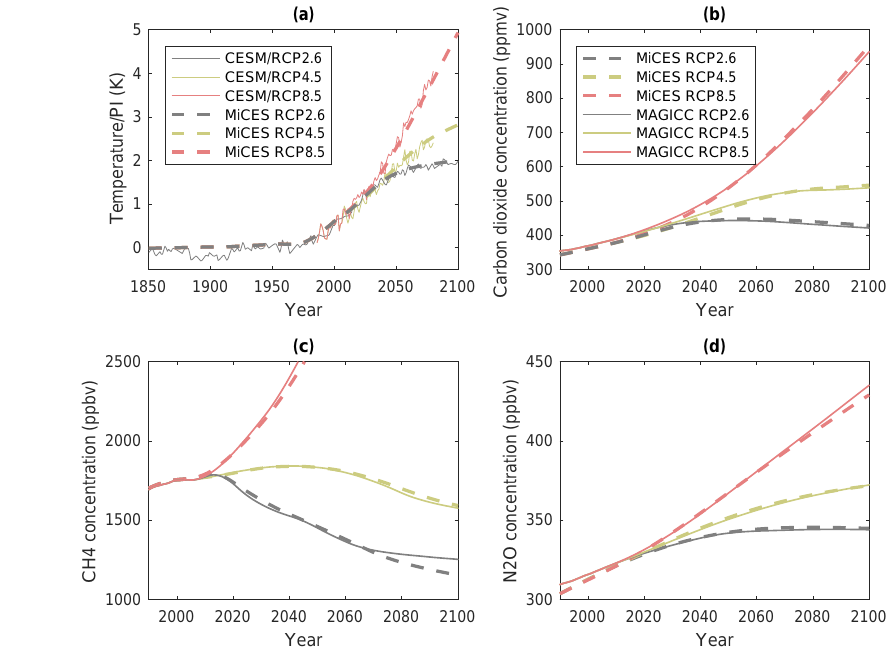
Figure B1. Calibrated behavior of the MiCES model in the context of the temperature targets (subplot a , target is CESM1-CAM5) and the concentration targets (subplots b–d , where target is MAGICC). In each case, the target is represented by a solid line, and the optimized MiCES simulation is represented by a dashed line. The colors represent the three scenarios used in calibration.